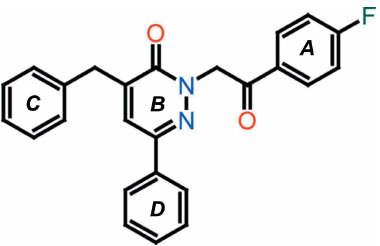
Table 1 Hydrogen-bond geometry (A˚ , (cid:3) ).